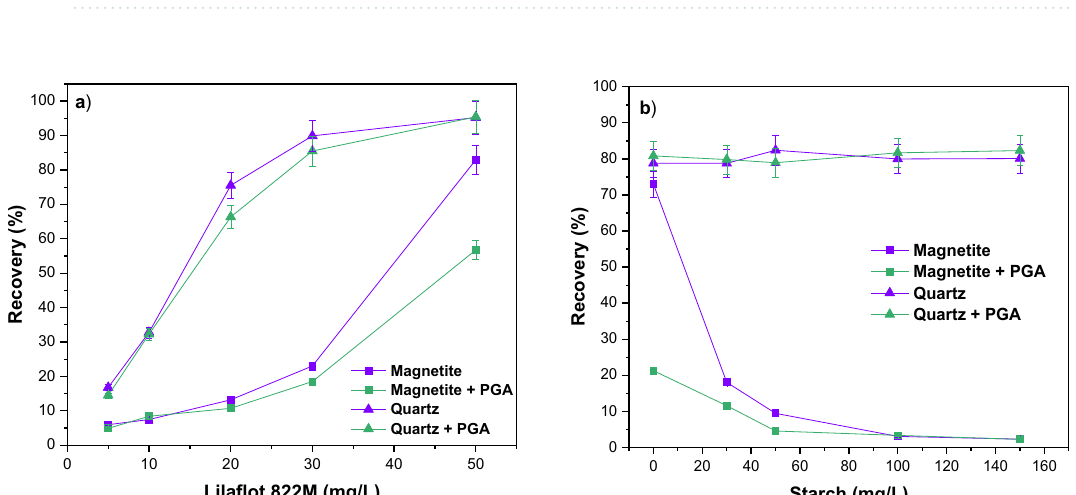
Figure 5. Single mineral flotation of magnetite and quartz as a function of ( a ) collector concentration in the presence and absence of 100 mg/L PGA at pH 10 and ( b ) depressant concentration in the presence and absence of 100 mg/L PGA at pH 10 and collector concentration of 50